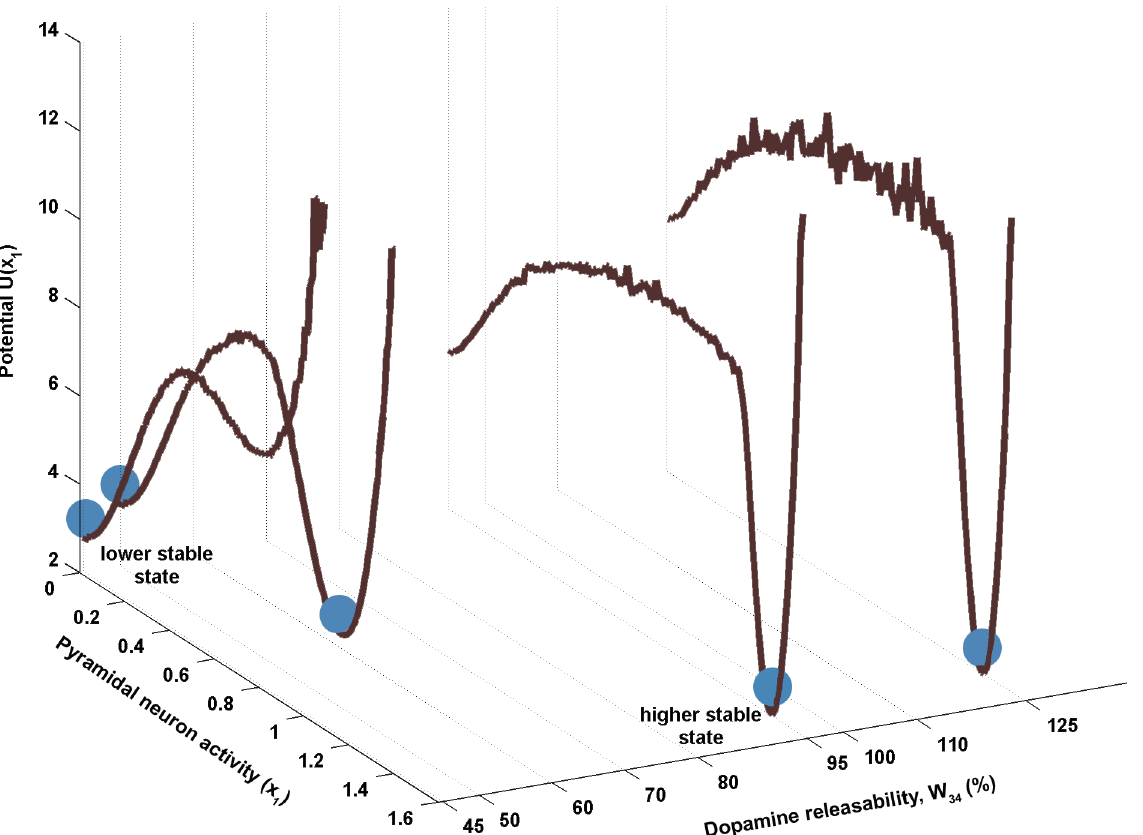
Fig 5. Global potential landscape w.r.t the pyramidal neuron activity x 1 , for different values of DA releasability W 34 . The profiles are obtained from the steady state distributions in variable x 1 for different values of W 34 . Here, the lower stable state represents the spontaneous-activity state and the higher stable state represents the sustained-firing state (working memory state) of the system. The system has been depicted by a ball sitting in the potential wells belonging to the different activity states. At low W 34 , the system (ball) prefers to rest in the well associated with the lower stable state as it is relatively more robust in comparison to its corresponding higher stable state. However, with the increase in W 34 , the higher stable state gradually becomes more robust relative to the corresponding lower stable state.